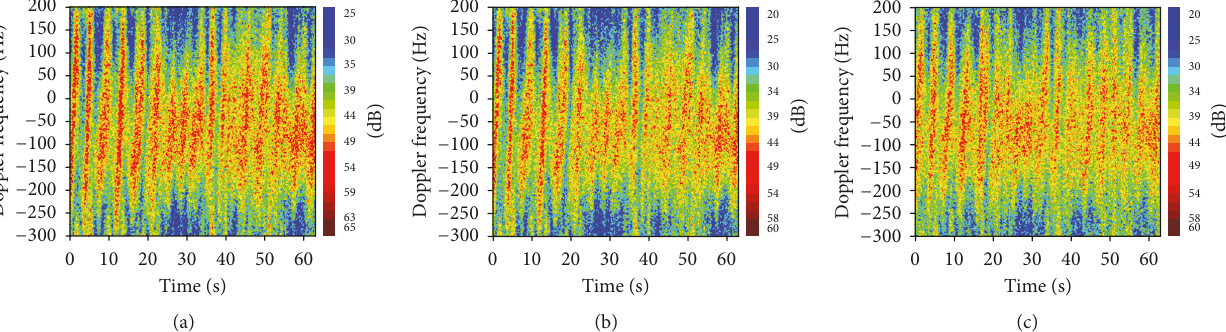
Figure 21: Examples of time Doppler maps, the 202nd range cell: (a) sum channel. (b) Elevation difference channel. (c) Azimuth difference